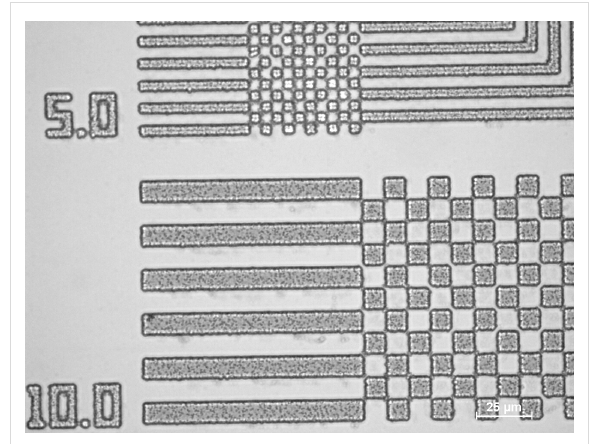
Figure 5: Microscope image at 50× magnification of a nanocomposite containing 0.5 mL of 125 mg·mL − 1 AgNO 3 precursor solution after structuring using UV